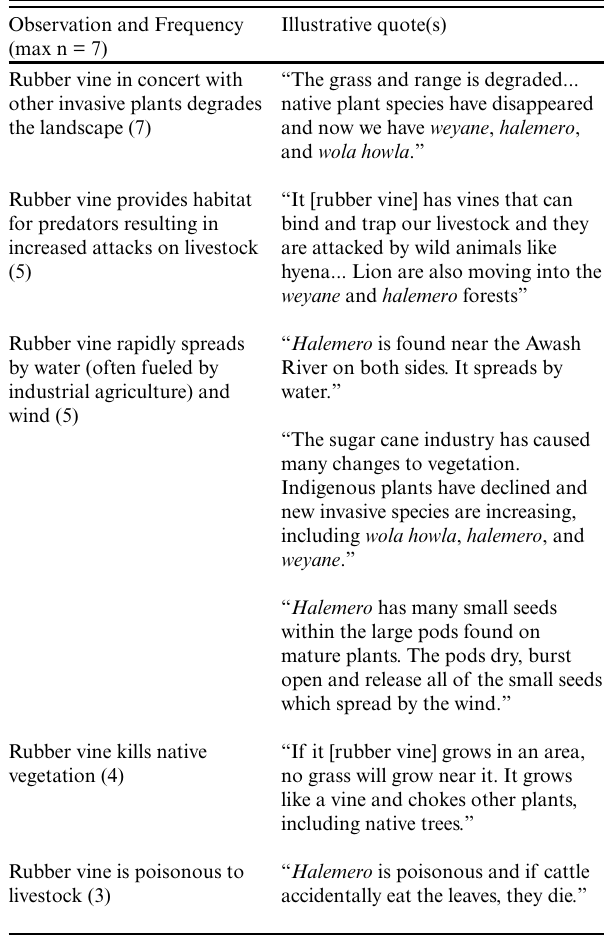
Table 1. Pastoralist observations of rubber vine ( Cryptostegia grandiflora ) dispersal mechanisms, threats, and negative impacts across the seven village focus groups with illustrative quotes. Frequency denotes the number of villages that made the same observation. Local plant names are in italics, including halemero (rubber vine), weyane ( P. juliflora ), and wola howla ( P. hysterophorous